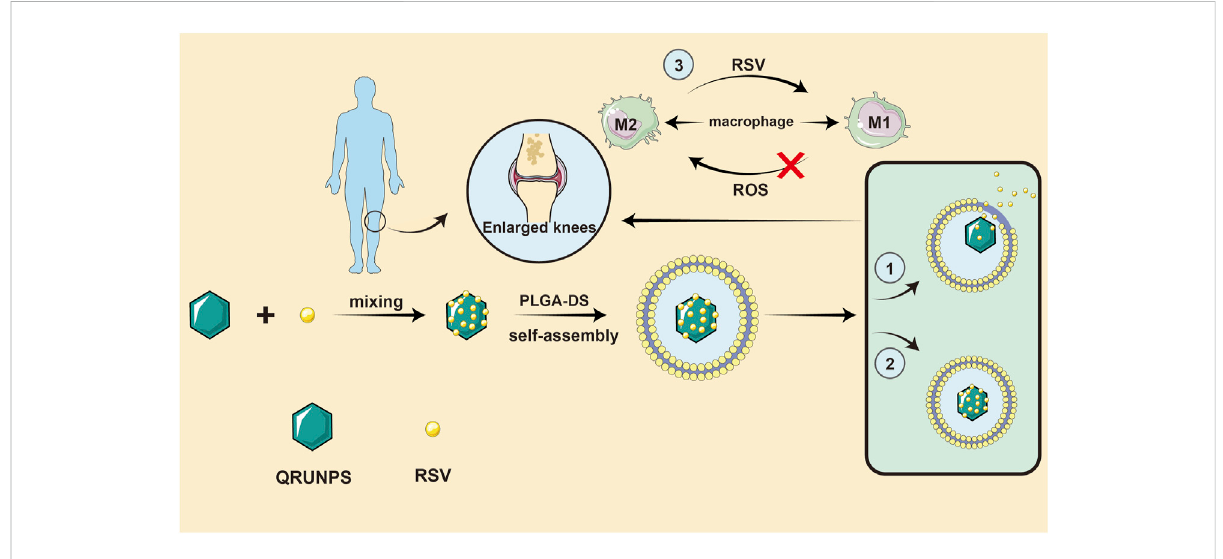
FIGURE 4 A drug delivery system idea for resveratrol. QRU-PLGA-RES-DS nanoparticles can effectively aggregate at the lesion site, promote the transformation of M2 macrophages, and reduce the recruitment of M1 macrophages, so as to effectively treat RA by eliminating an in fl ammatory